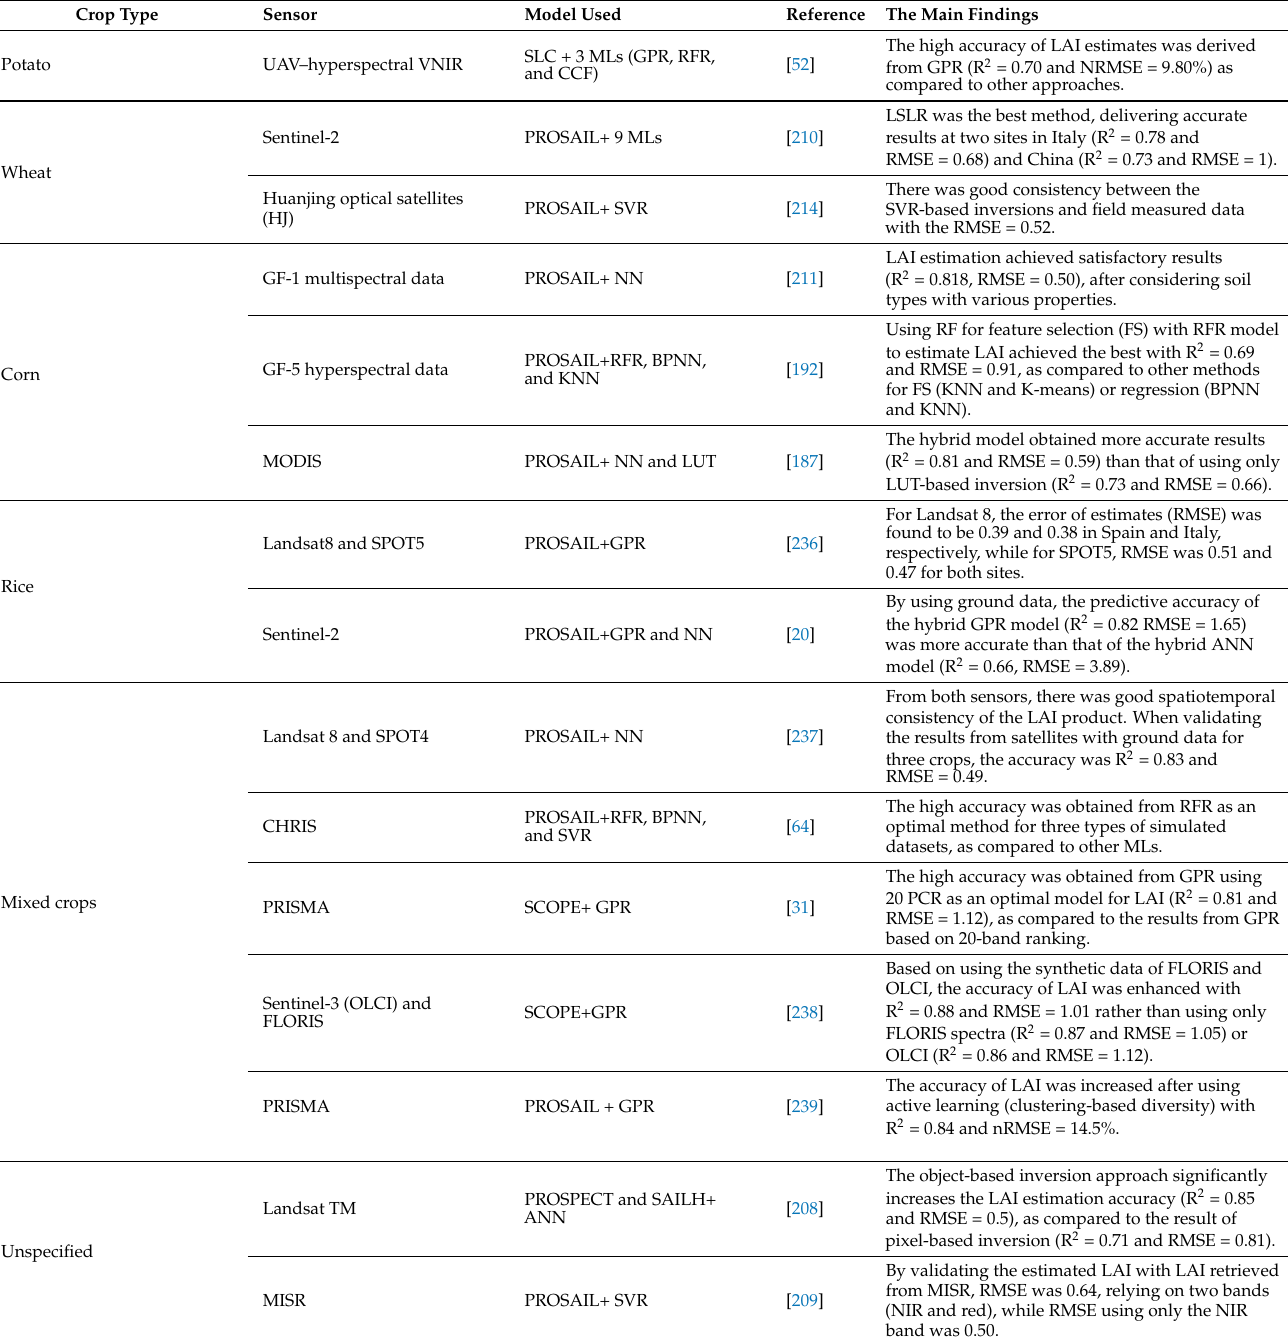
Table A4. Summary of example studies using nonparametric method for LAI